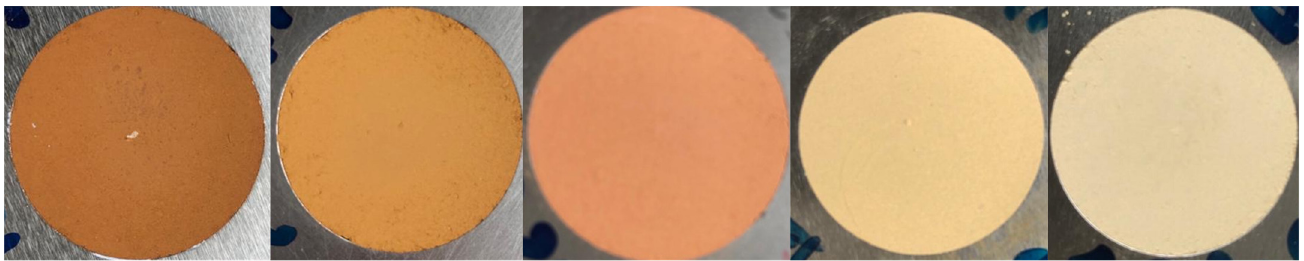
Figure 3. Selected nickel laterite samples prepared for XRD measurements representing five main groups in the nickel laterite profile, left = high goethite, right = high lizardite.